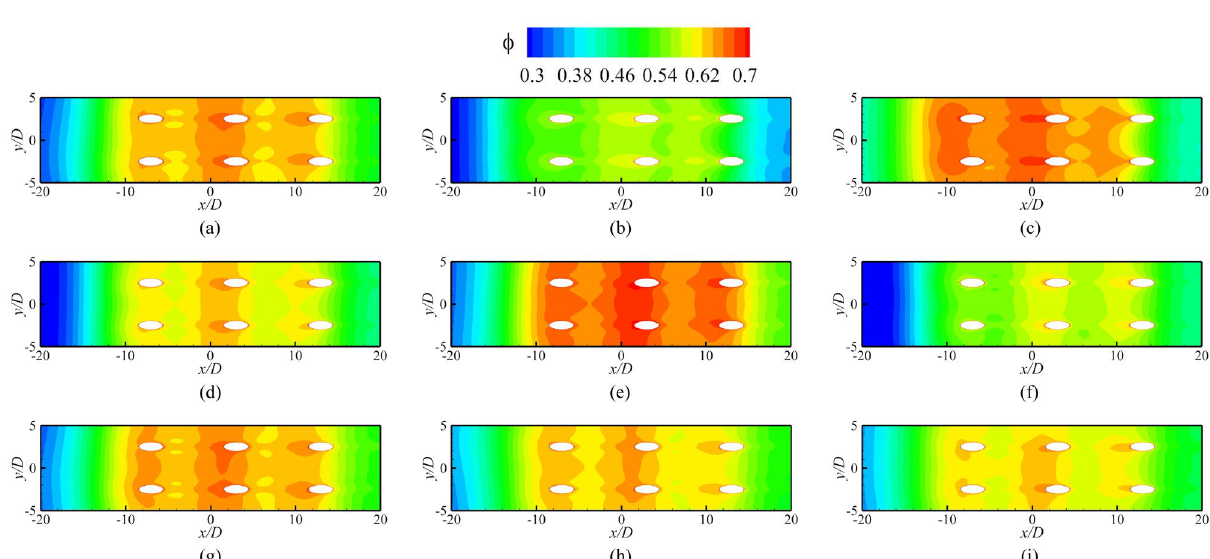
Figure 14. Contours of overall cooling effectiveness for impingement effusion model. ( a ) Ref-case #2; ( b ) Overlapped; ( c ) Span parallel; ( d ) Streamwise parallel; ( e ) D imp = 1.5 D ; ( f ) D imp = 2.5 D ; ( g ) t gap = 5 D ; ( h ) t gap = 10 D ; ( i ) t gap = 15 D